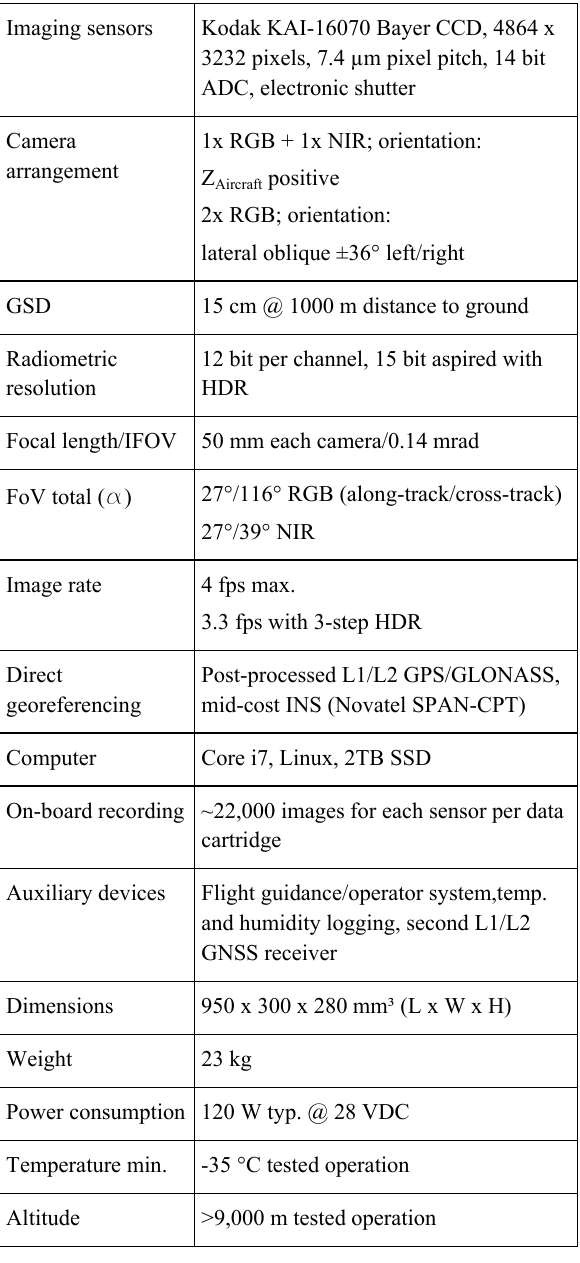
Table 3. Technical data of the MACS-Himalaya aerial camera